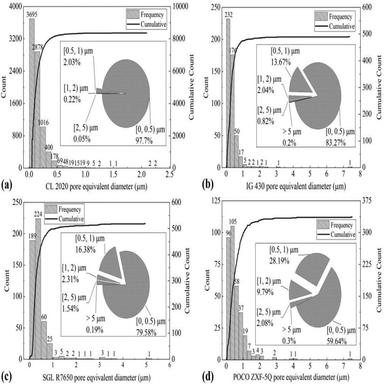
Statistics of pore equivalent diameter for the four grades of graphite at sub-micrometre length scale from FIB tomographic data: (a) CL 2020 graphite, total pore number: 8359 and, (b) IG 430 graphite, total pore number: 490 and, (c) SGL R7650 graphite, total pore number: 519 and, (d) POCO ZXF-5Q graphite, total pore number: 337.